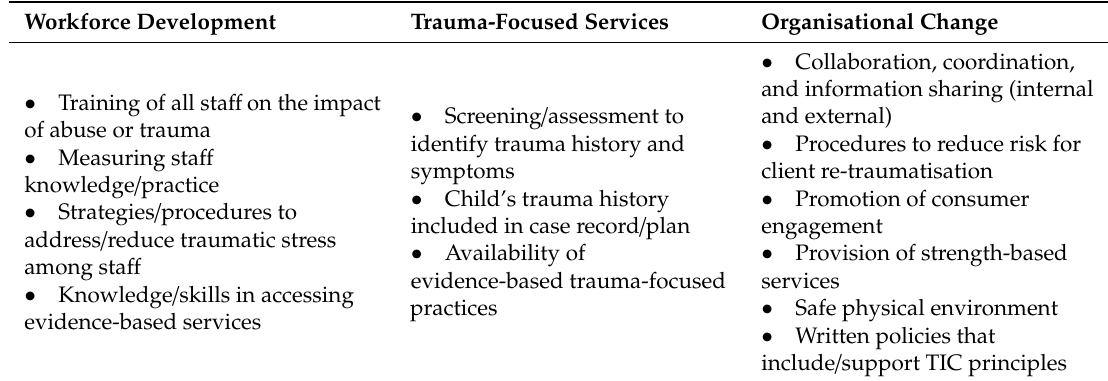
Table 1. Domains of trauma informed implementation in child welfare systems (Hanson and Lang, 2016)